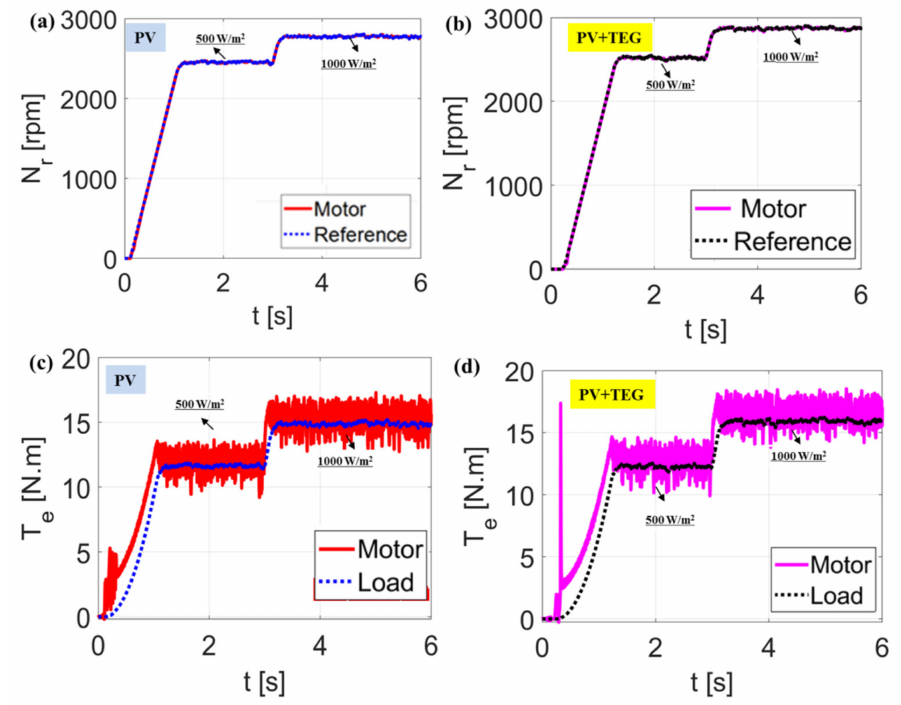
Figure 9. The SynRM speed versus time under 0.5 KW/m 2 to 1 KW/m 2 ( a , b ). The SynRM torque versus time under 0.5 KW/m 2 to 1 KW/m 2 ( c , d ).